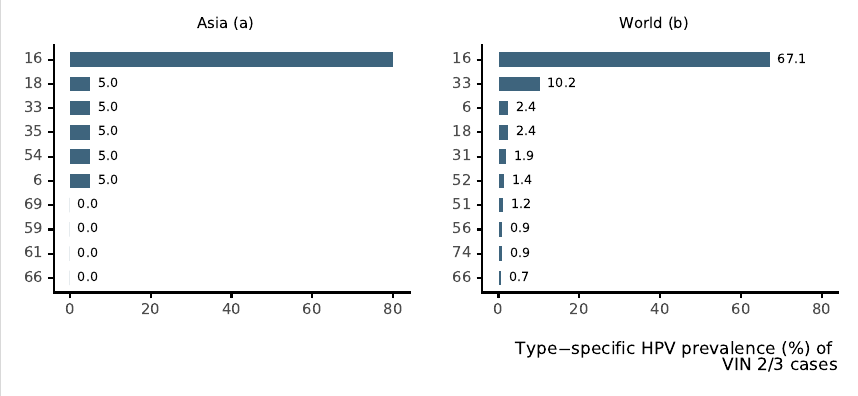
Figure 65: Comparison of the ten most frequent HPV types in VIN 2/3 cases in Asia and the